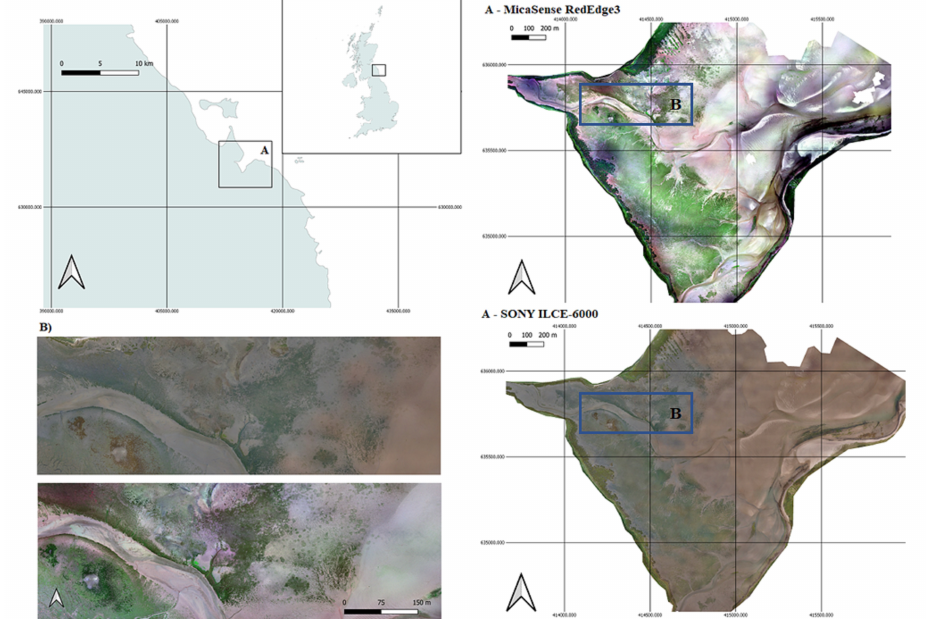
Figure 1. Site location within the U.K. and Northumberland ( top-left ). Ortho-registered images of Budle Bay using a SONY ILCE-6000 and a MicaSense RedEdge 3 ( right ). And close-ups of dendritic channels along the North-Western portion of the site ( bottom-left ). For the display of the latter camera, we use the Red, Green and Blue image